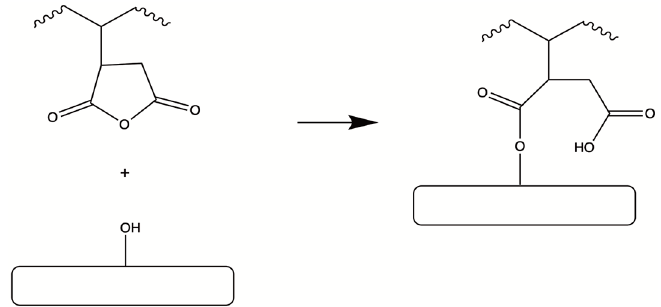
Figure 6. Schematic representation of the ring-opening of ITA by superficial hydroxyl groups present on the reinforcement.